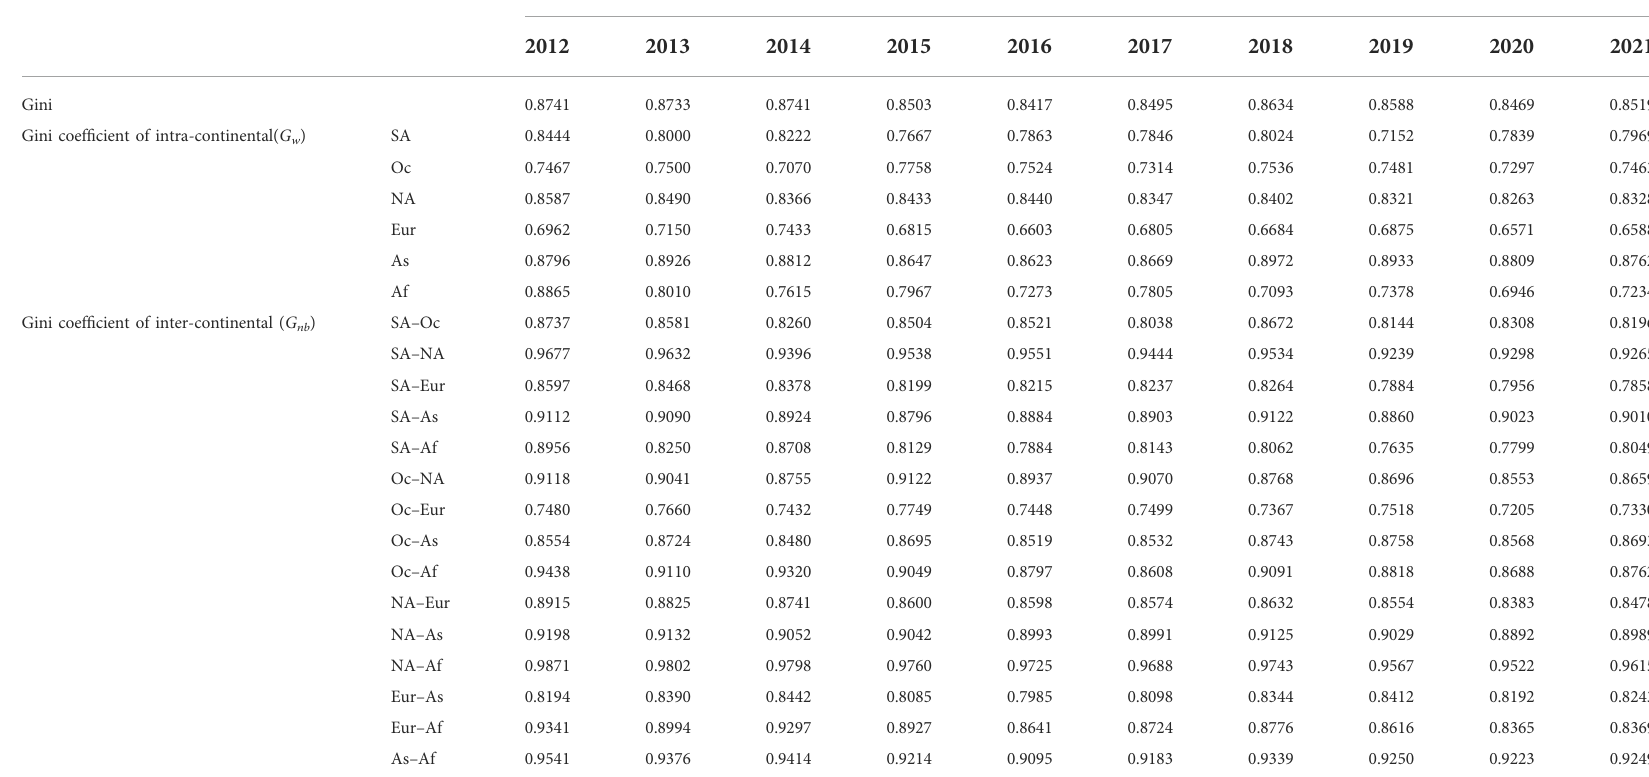
TABLE 3 Gini coef fi cient and decomposition results of the output of remote sensing